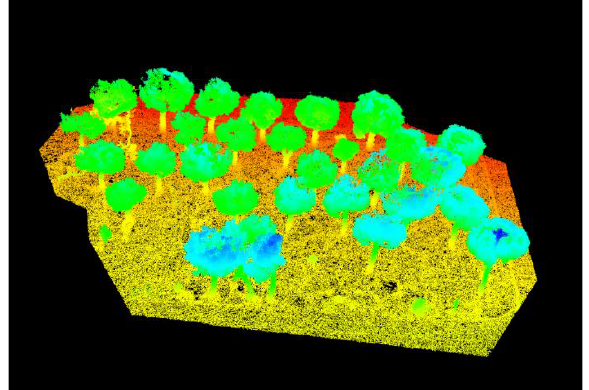
Figure 5. HMSL data imported into 3D Forest and colored by Z